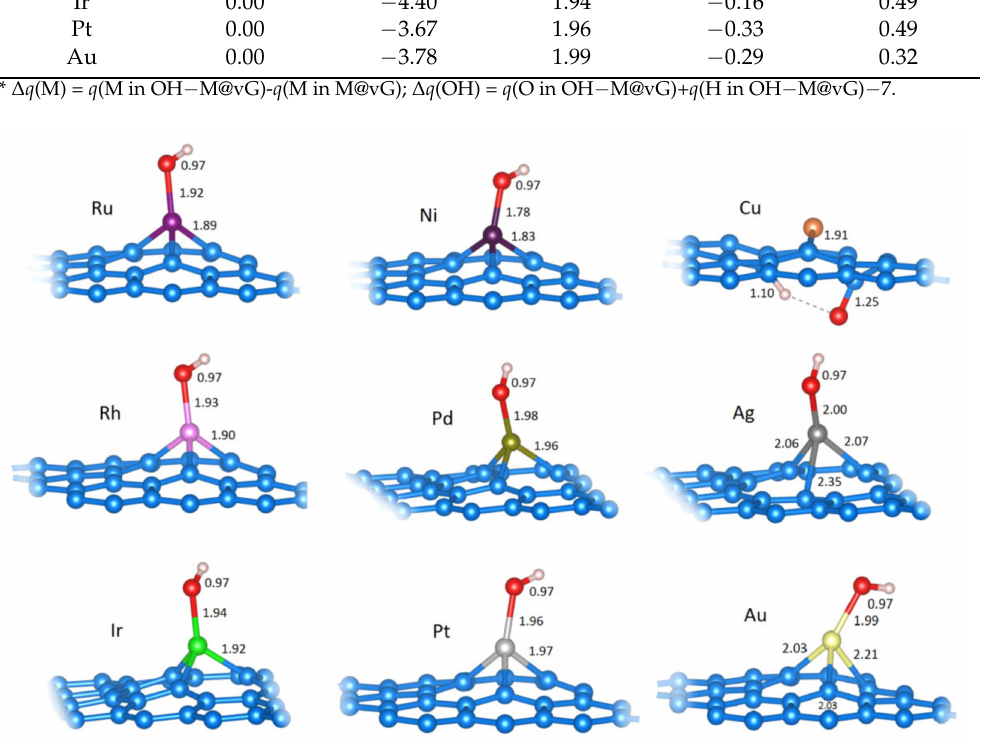
Figure 5. The relaxed structures of OH on the most favorable positions on C 31 M systems (M is labeled for each structure). Bond lengths for H − O or H − C, O − M or O − C, and M − C are given in Å (if all bonds between two same atom types are of equal length, only one such length is indicated). Structural models were made using VESTA